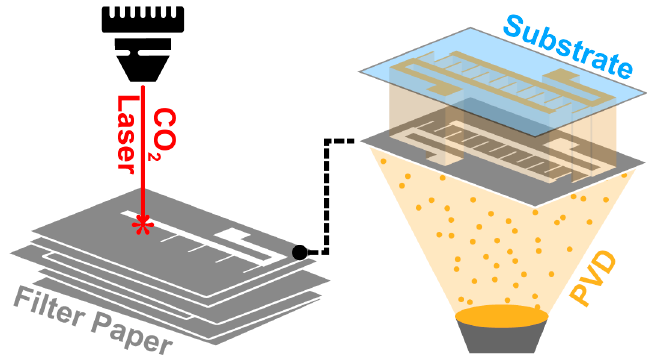
Figure 1. Schematic illustration of our approach. We employ a CO 2 laser to pattern quantitative filter paper ( left ). The laser-cut paper, placed between a PVD materials source and a substrate, functions as a shadow mask for pattern transfer ( right ).